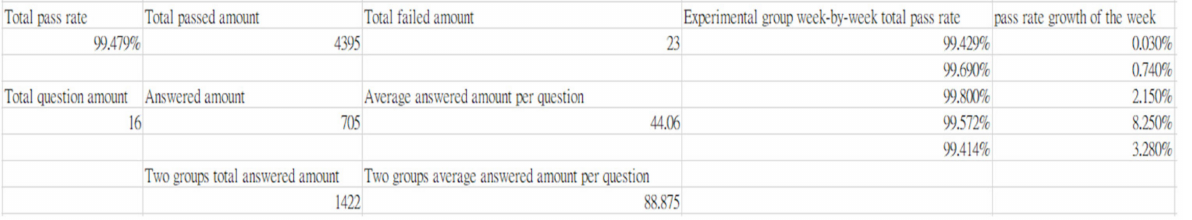
Figure 37. Total pass rate and various data analyzed in the above-mentioned